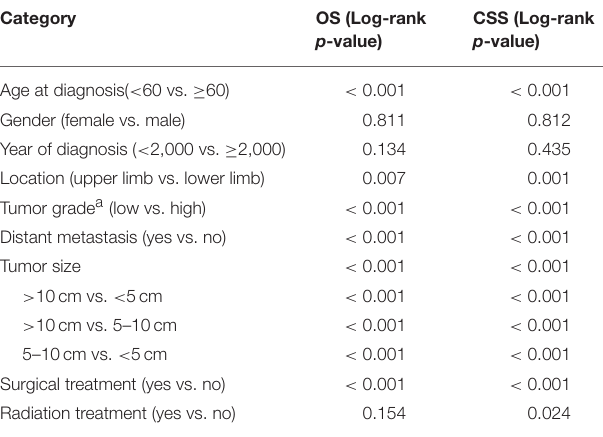
TABLE 3 | Multivariate analysis for OS and CSS in the training